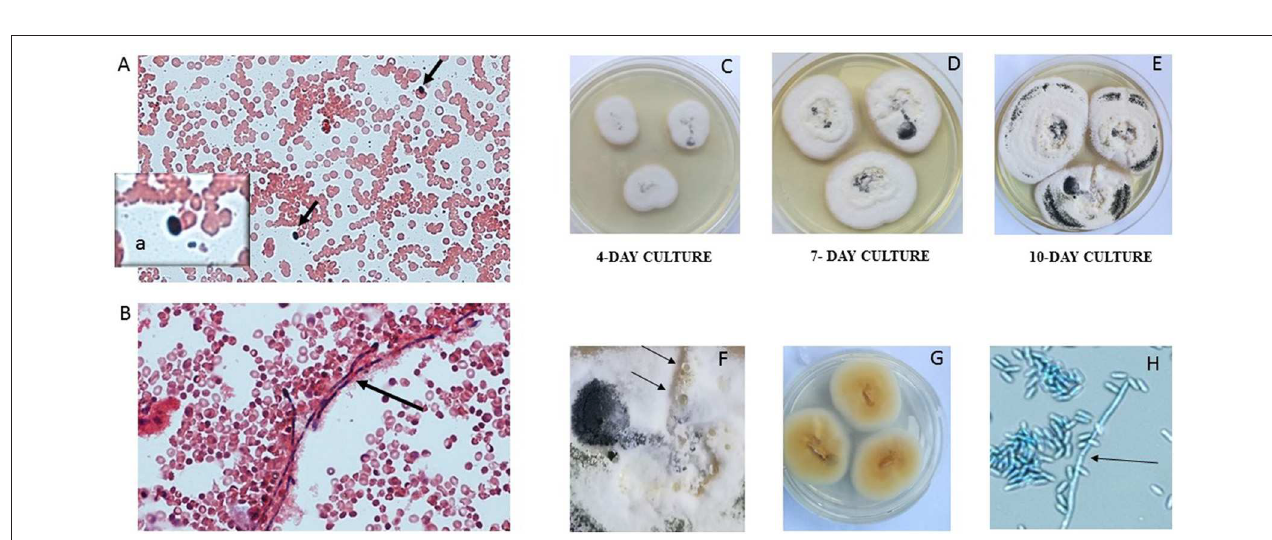
FIGURE 2 | Presence of conidia ( A , black arrows and inset a) and hyphae ( B , black arrow) in the blood culture (20 × magnification, Gram stain). The mold isolated from blood culture was subcultured on Sabouraud dextrose at 30 ◦ C. A. verrucaria colonies were flat, smooth, moist, white to cream, with regular and sharp margins ( C–E growth over 10 days). The colonies developed a black pigment represented more and more along the days of culture and produced serous vesicles ( F , black arrows). The reverse was yellow to orange (G) . Septate hyphae ( H , black arrow) and grapes of conidia (H) were present on microscopic examination (lactophenol cotton blue, 40 ×